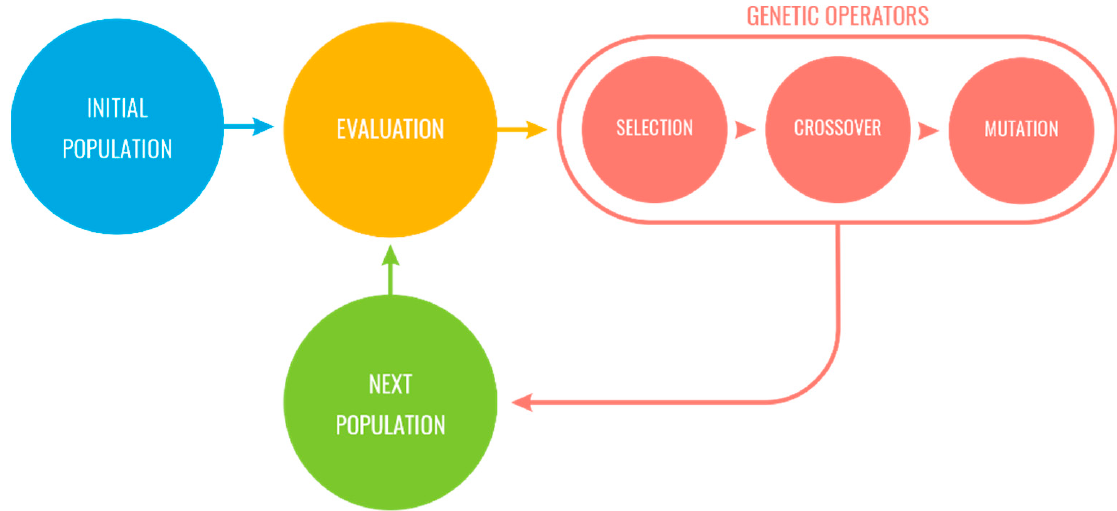
Figure 3. General scheme of a genetic algorithm.